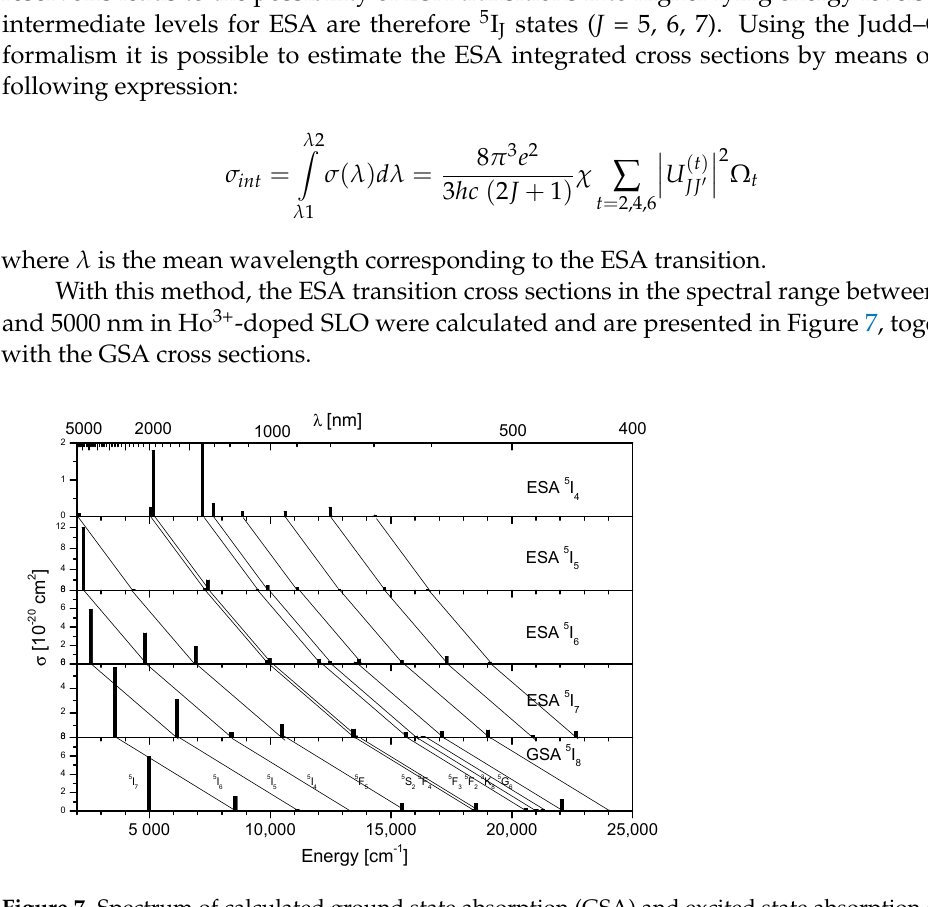
Figure 7. Spectrum of calculated ground state absorption (GSA) and excited state absorption (ESA) integrated cross sections σ in SrLaGaO 4 :Ho 3+ crystal.